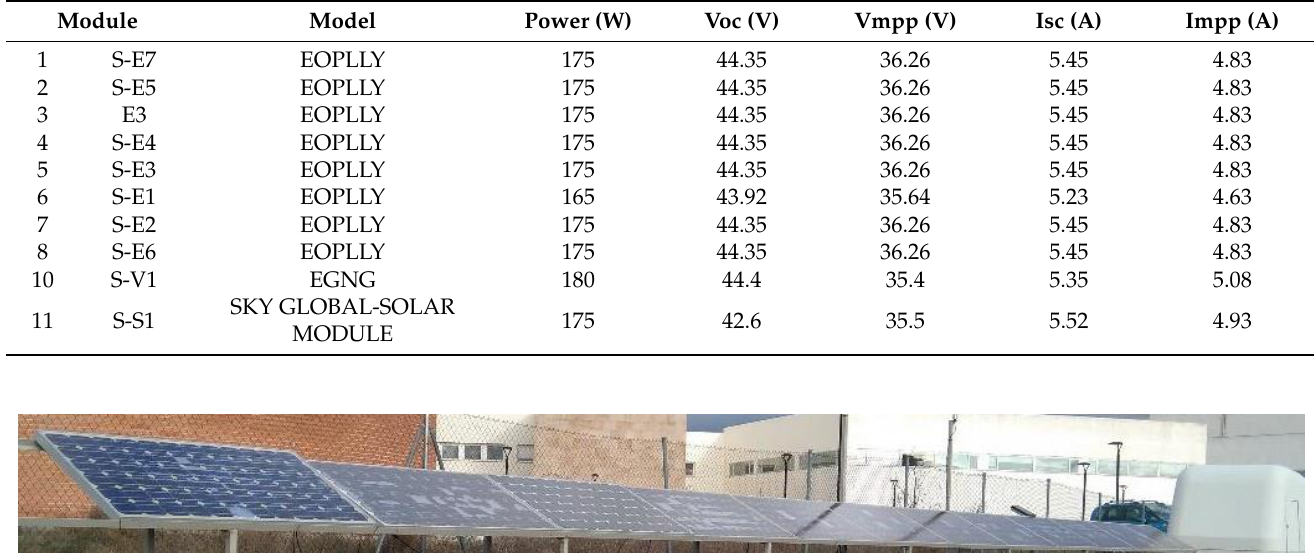
Table 1. Main nominal data of photovoltaic (PV) modules.